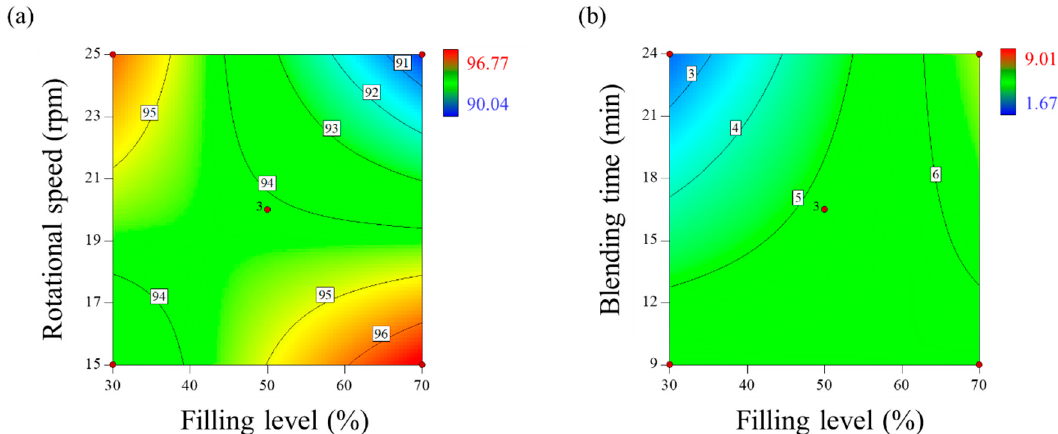
Figure 3. Two-dimensional contour plots to optimize process parameters for blending of amlodipine formulation: ( a ) drug content (%) and ( b ) content uniformity (CU) (%).